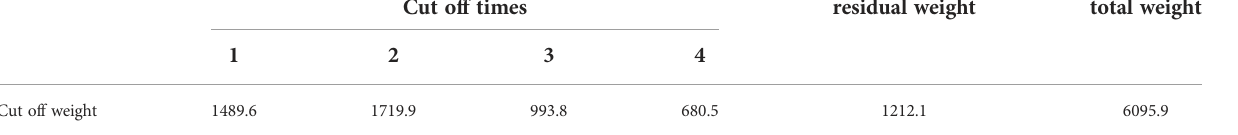
TABLE 1 Statistics of four pruning of wheat